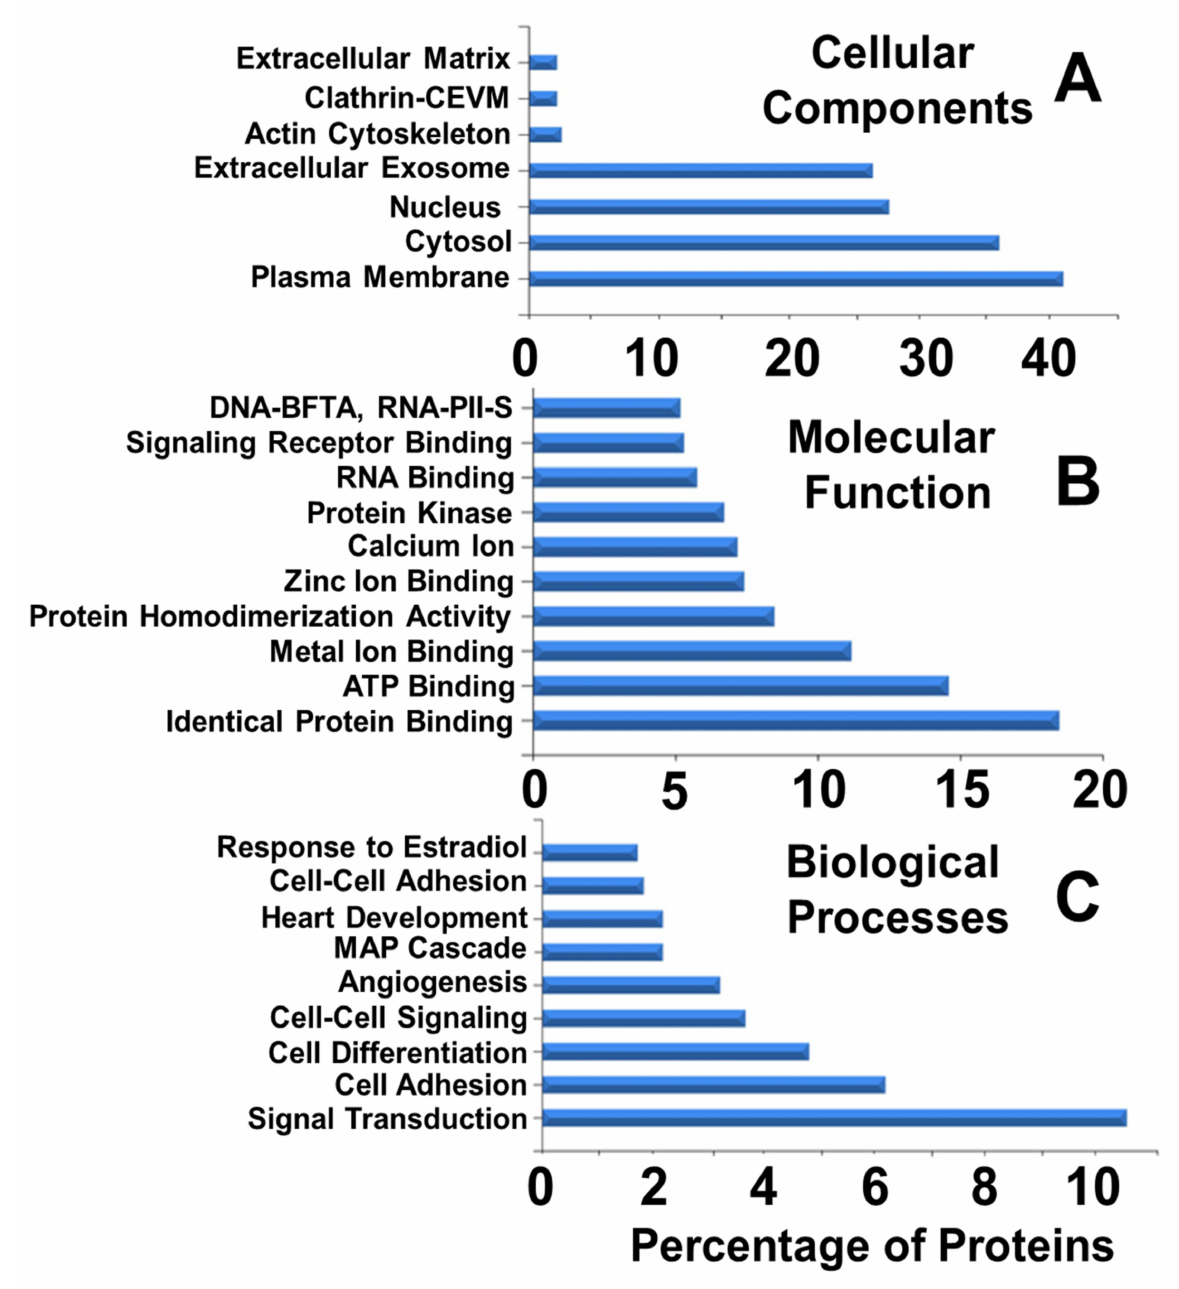
Figure 3. Analysis of the differentially expressed proteins modulated by E2 shows a significant over-representation (False Discovery Rate corrected p -value < 0.05) of the proteins participating in biological pathways, biological processes, cellular components and molecular functions. FunRich analysis of all the 2381 proteins which were commonly identified in both vehicle treated control MSCs and MSCs treated with E2 were characterized on their cellular components ( A ), biological pathways ( B ), molecular functions ( B ) and biological processes ( C ). DNA-BFTA, DNA-binding transcription factor activity; RNA-PII-S, RNA polymerase II-specific; and Clathrin-CEVM, Clathrin-coated endocytic vesicle